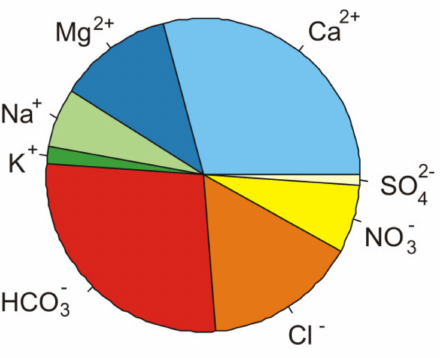
Figure 1. The chemical composition of the water in sedimentation tank is of the bicarbonate-calcium